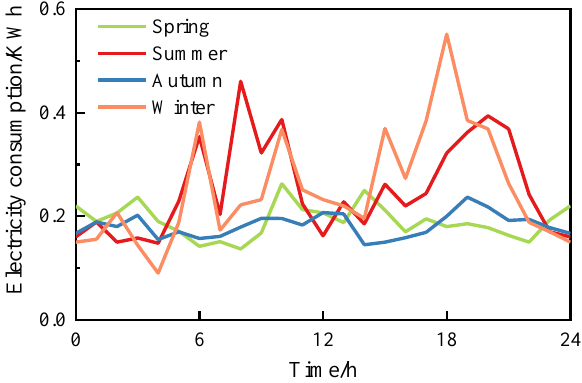
Figure 5. Daily load consumption curves in the different seasons.